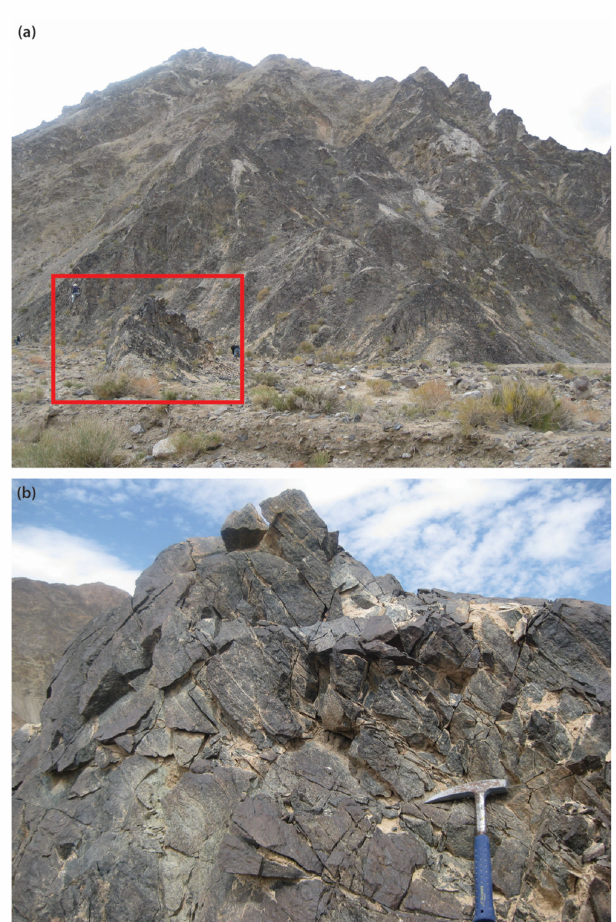
Figure 2. Photographs of the Xitieshan outcrop. ( a ) Large view of the Xitieshan Mountain con- taining retrograded eclogites and ( b ) magnified view of the rectangle in ( a ) showing a body of retrograded